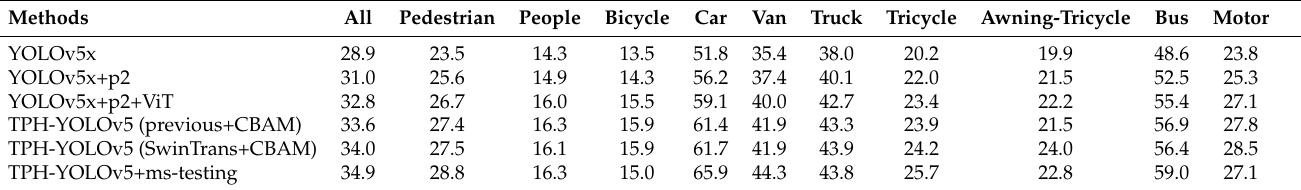
Table 7. Ablation study for each category on the VisDrone2021 test-dev set. The AP of each category is used as the